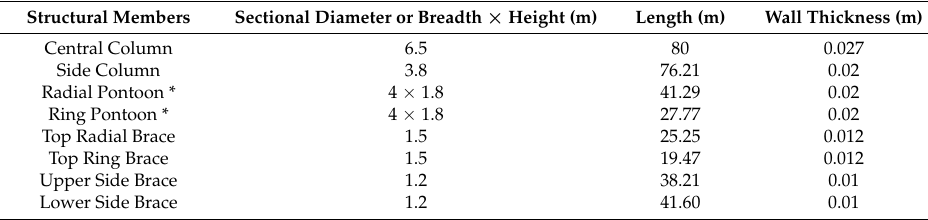
Table 1. Dimensions of fishing cage structural members.